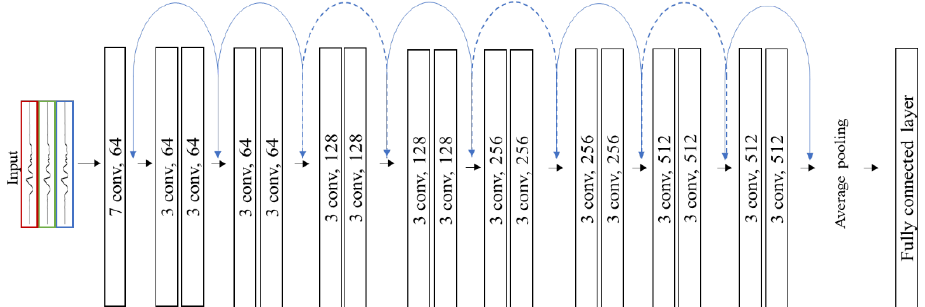
Figure 3. ResNet-18 convolutional neural network architecture. The dotted blue lines represent the residual connections (or skip connections) utilised in this network. Conv = convolutional layers. The final fully connected layer acts as the output layer for binary classification (i.e., sitting or breaking up sitting or 9-h or 5-h sleep